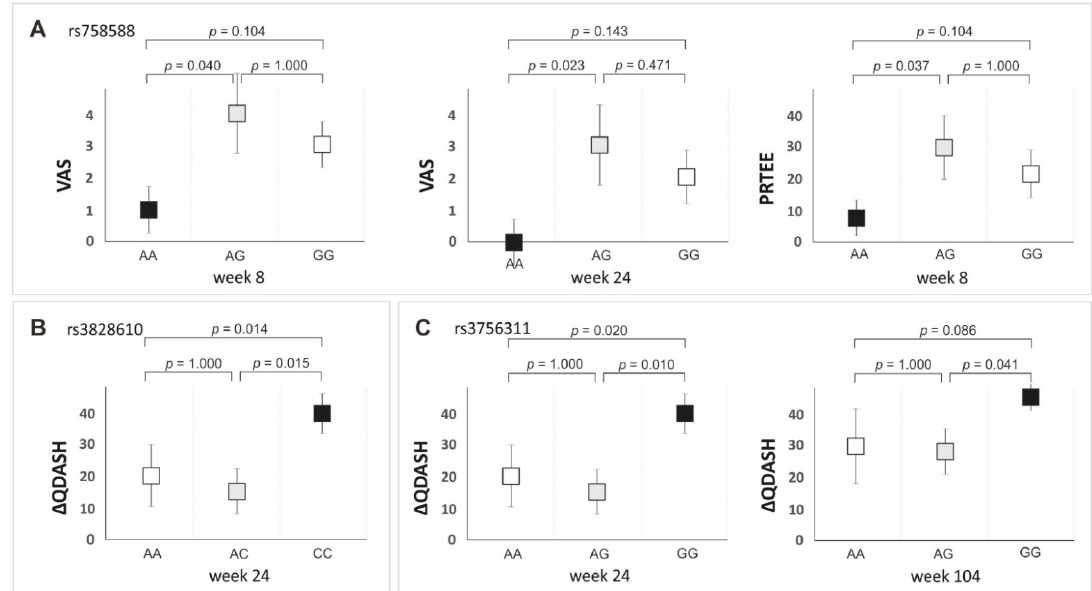
Figure 4. Medians (±QD) of PROMs values for genotype variants of the PDGFRB gene polymor- phisms in the additive model: ( A ) VAS, weeks 8 and 24, PRTEE week 8 for rs758588; ( B ) Δ QDASH, week 24 for rs3828610; ( C ) Δ QDASH, weeks 24 and 104 for rs3756311 SNP. Statistically significant results ( p < 0.050) from the analysis of the effect of PDGFRB gene variants on PROMs values in the dominant/recessive model are presented in Figure 5. The detailed data (median ± QD, p- value) for each of the studied polymorphisms are presented in supplementary tables (Tables S5–S9).